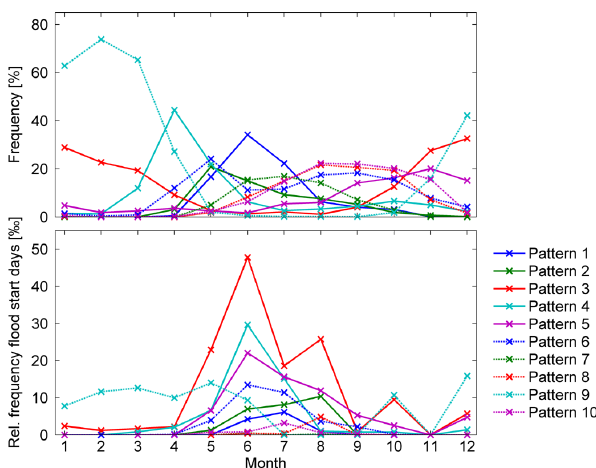
Fig. 7. Frequency of occurrence per month of different soil moisture pattern types [%] (top). Relative frequency of flood start days per month and respective soil moisture pattern type [‰]